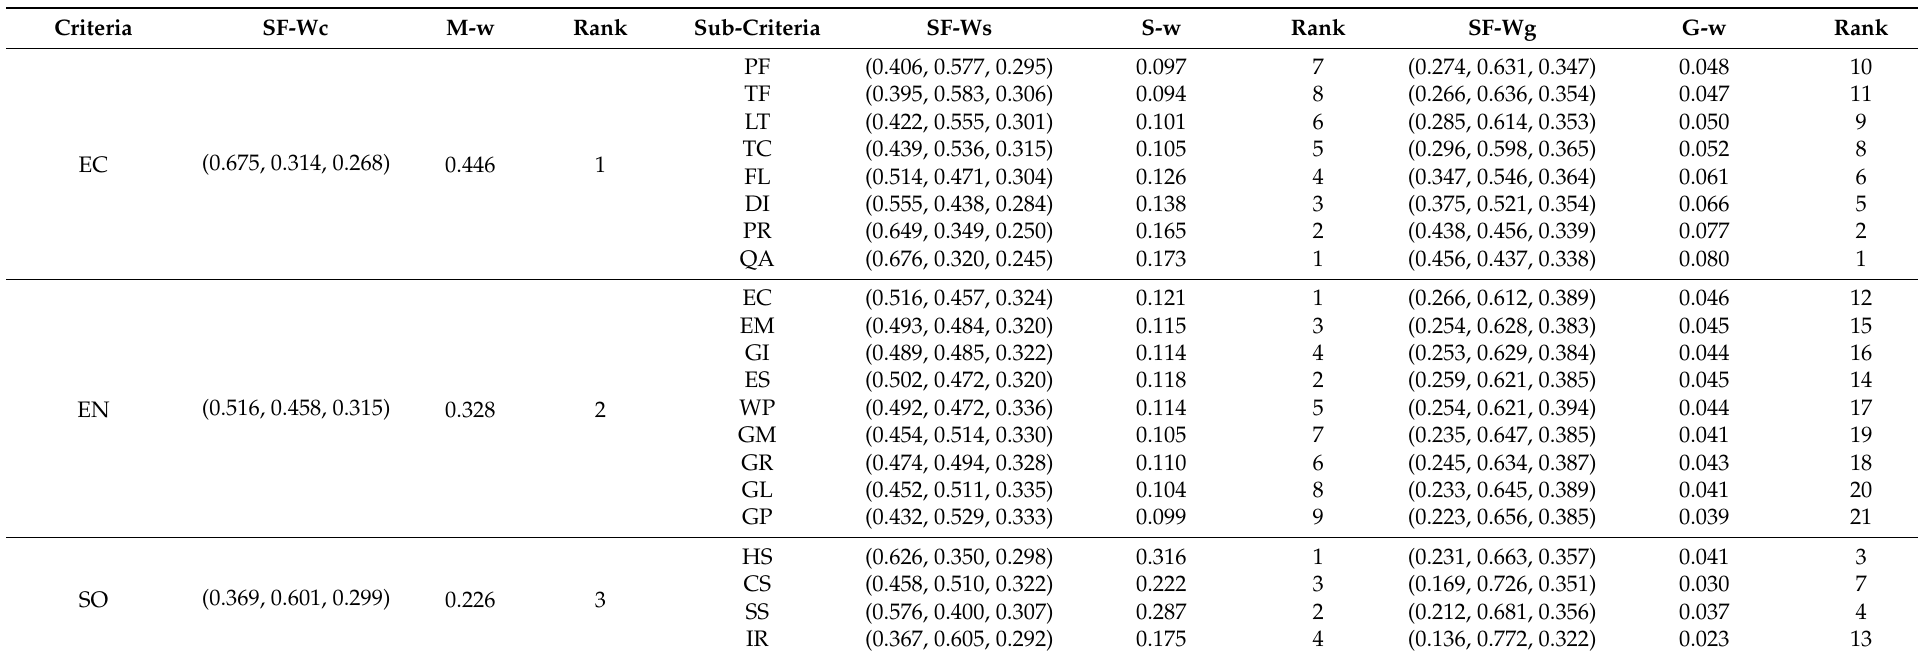
Table 13. Final rankings and weights